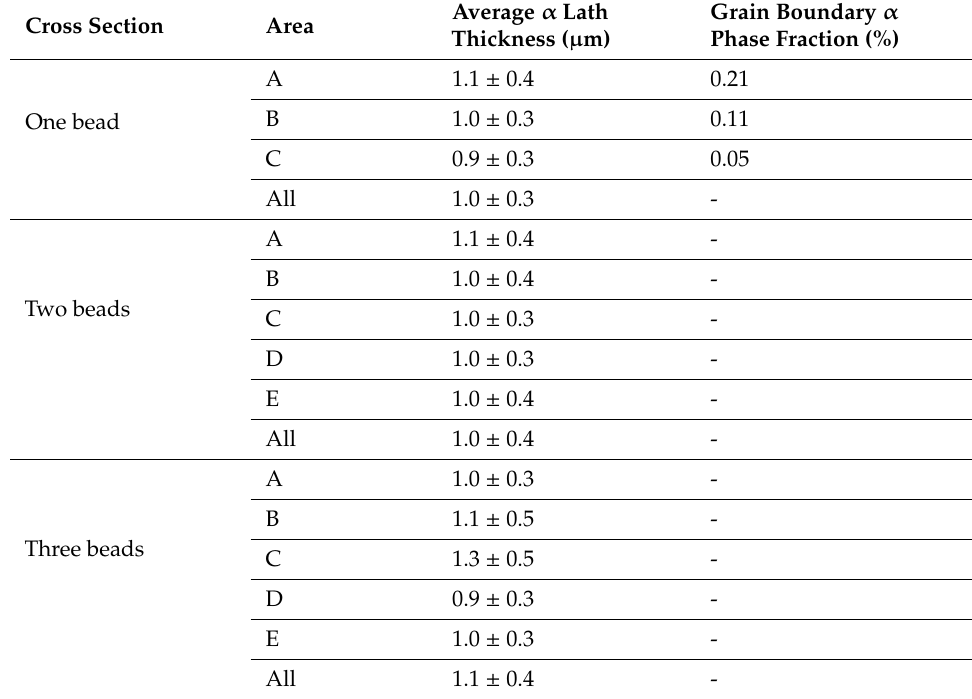
Table 3. The result of the quantitative material characterization of the three cross-sections containing widths of one, two, and three beads,